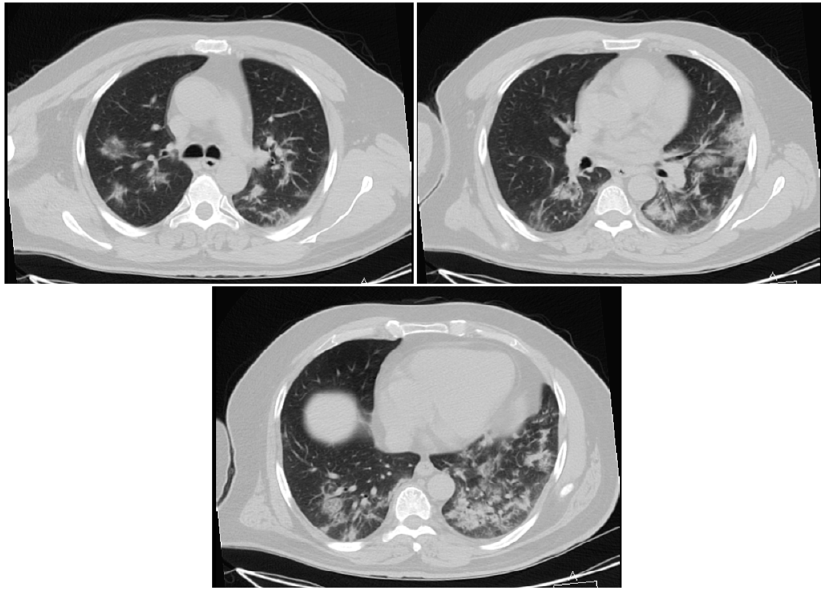
Figure 10. Chest MDCT scan, lung window, axial plane: Bilateral multilobar asymmetrical patchy ground glass opacities with random peribronchovascular and peripheral distribution more severe in left lung are seen.